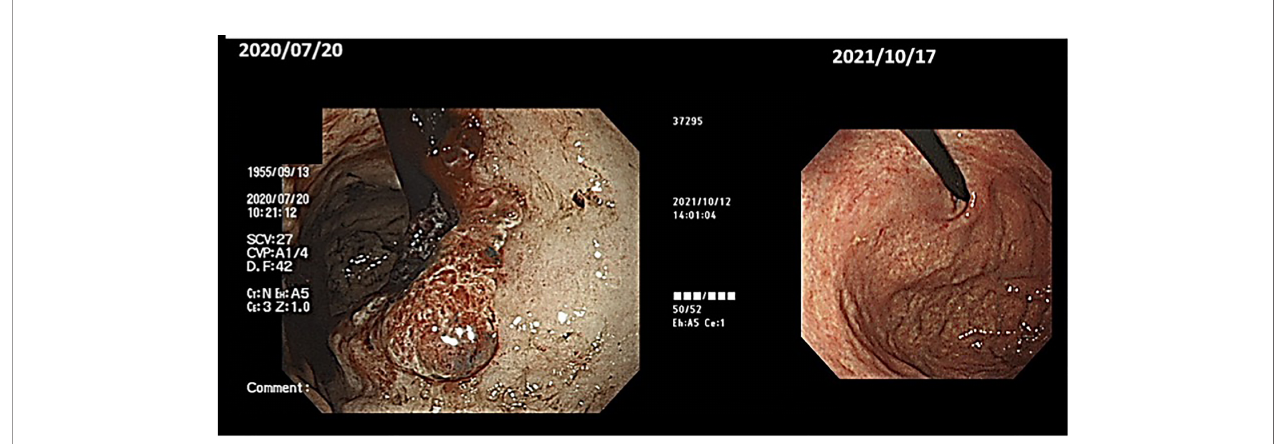
FIGURE 8 | An upper gastrointestinal endoscopy showed that tumors had